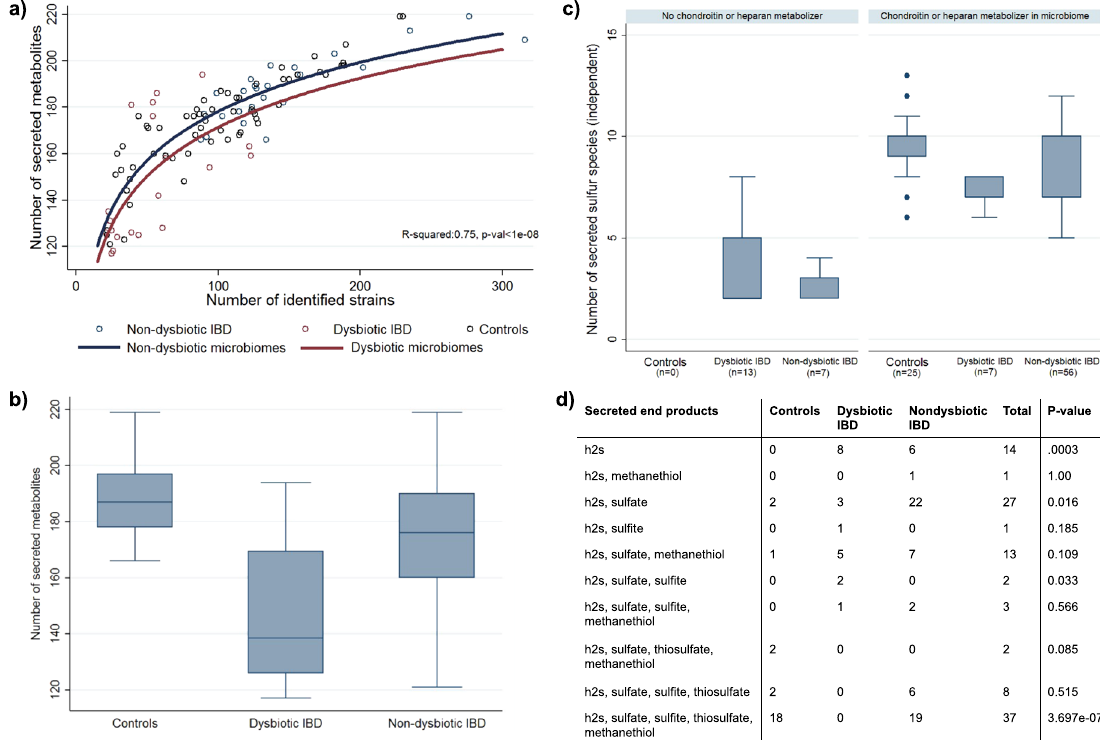
Fig. 4 Reduced metabolic diversity in dysbiotic IBD. a Logarithmic dependency of the number of secreted metabolites in dependency on the number of identi fi ed strains. Curves for dysbiotic (red) and non-dysbiotic (blue) microbiomes are statistically different ( b = − 6.81, 95% − CI: ( − 13.38; − 0.25), p = 0.042). b Box plots for the number of secreted metabolites for the three study groups. Differences across the three study groups are signi fi cant ( p < 1e-08). c Number of secreted not perfectly coupled sulfur species in dependency on study group and the presence of glycan-degrading species. The presence of glycan producing species mediates signi fi cantly the effects of the study group (mediation effect: 53.11%, 95% − CI:(28,64%;77.60%, p = 2.14e-05). d Distribution of secretion patterns of end products of bacterial sulfur metabolism across the study groups. Abbreviations for metabolites are from https://www.vmh.life. p -values were derived from Fisher ’ s exact test. In the box plots, the centre lines represent the median; box limits represent upper and lower quartiles; whiskers represent 1.5x interquartile